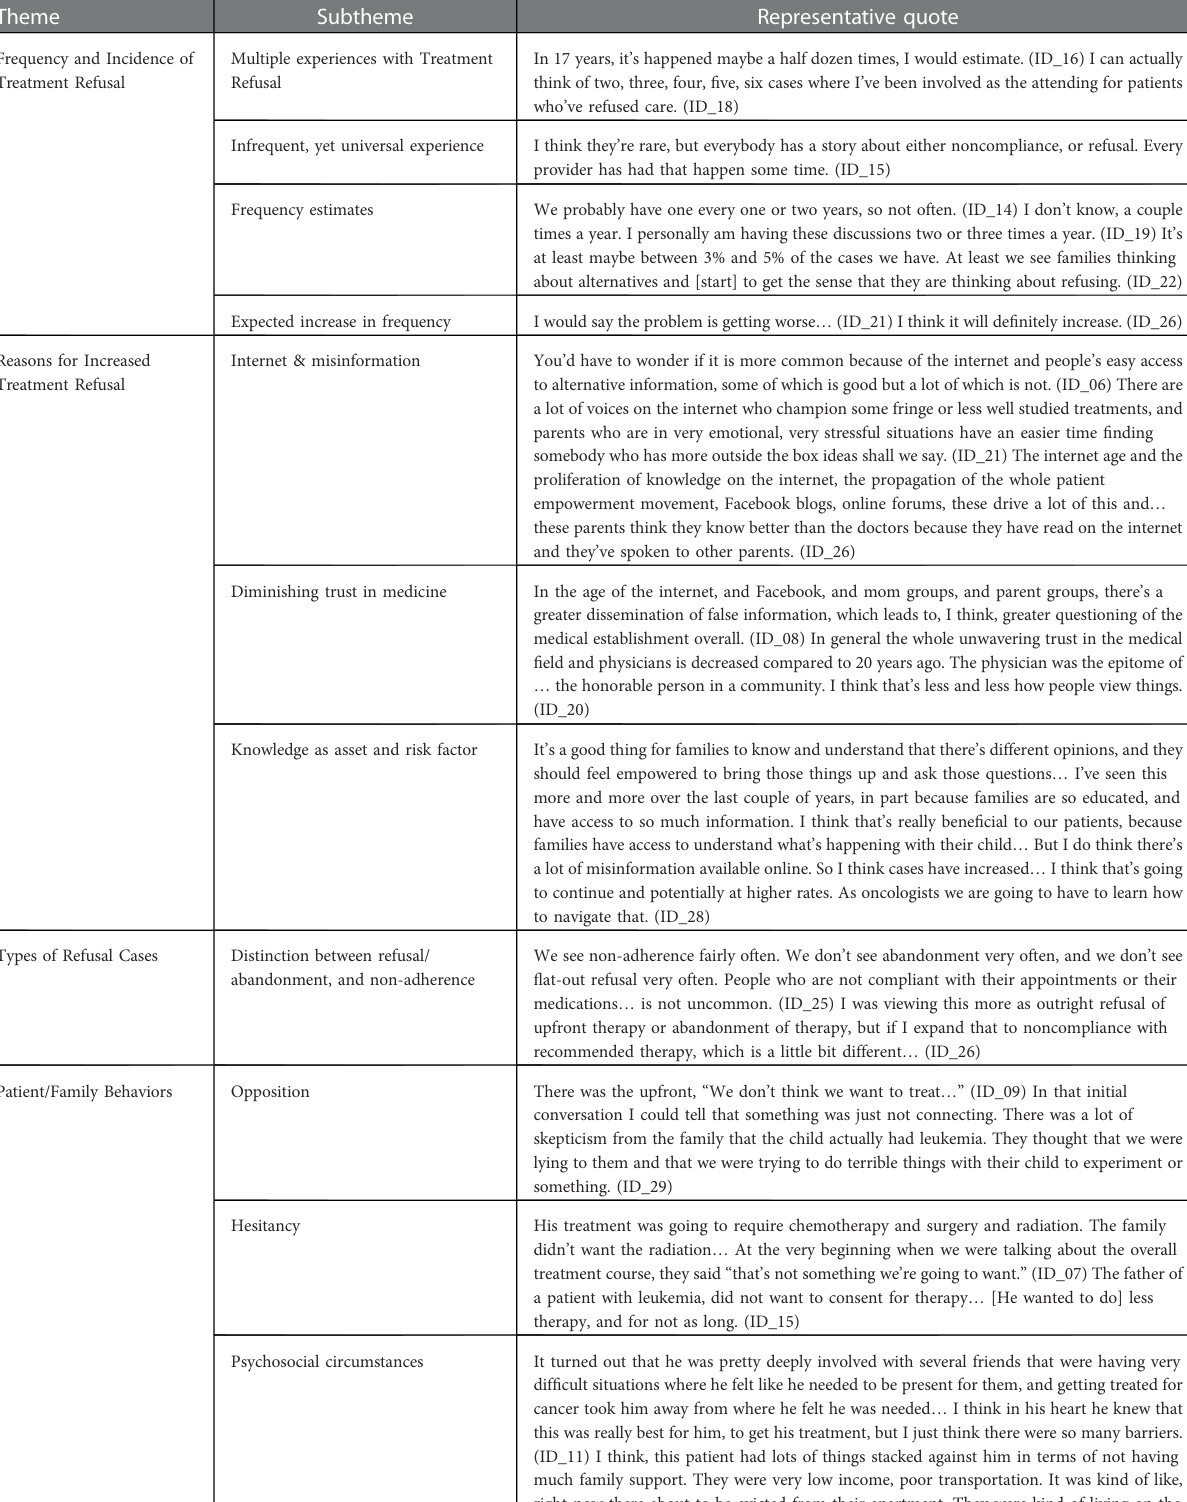
TABLE 3 Themes with illustrative quotes.